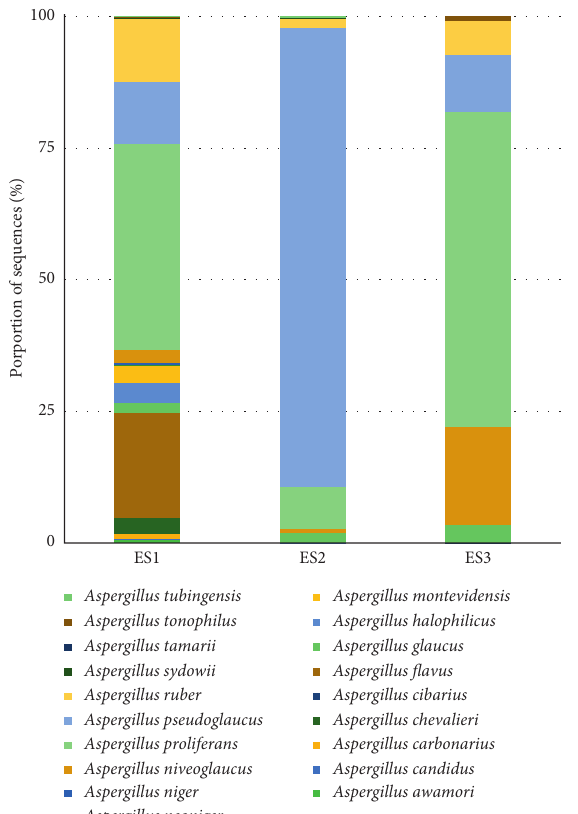
Figure 4: The percentage of Aspergillus species based on HTS of the CaM amplicon for all three E. sinensis